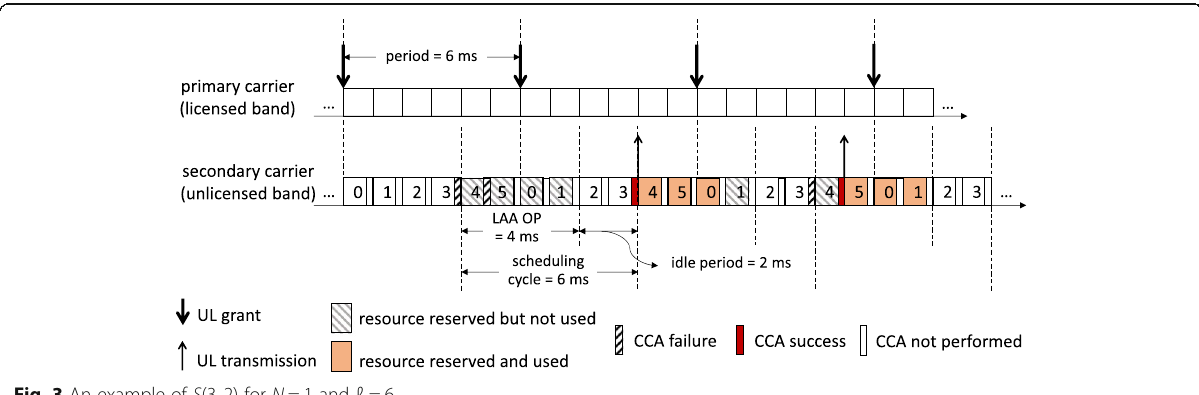
Fig. 3 An example of S (3, 2) for N = 1 and ℓ =